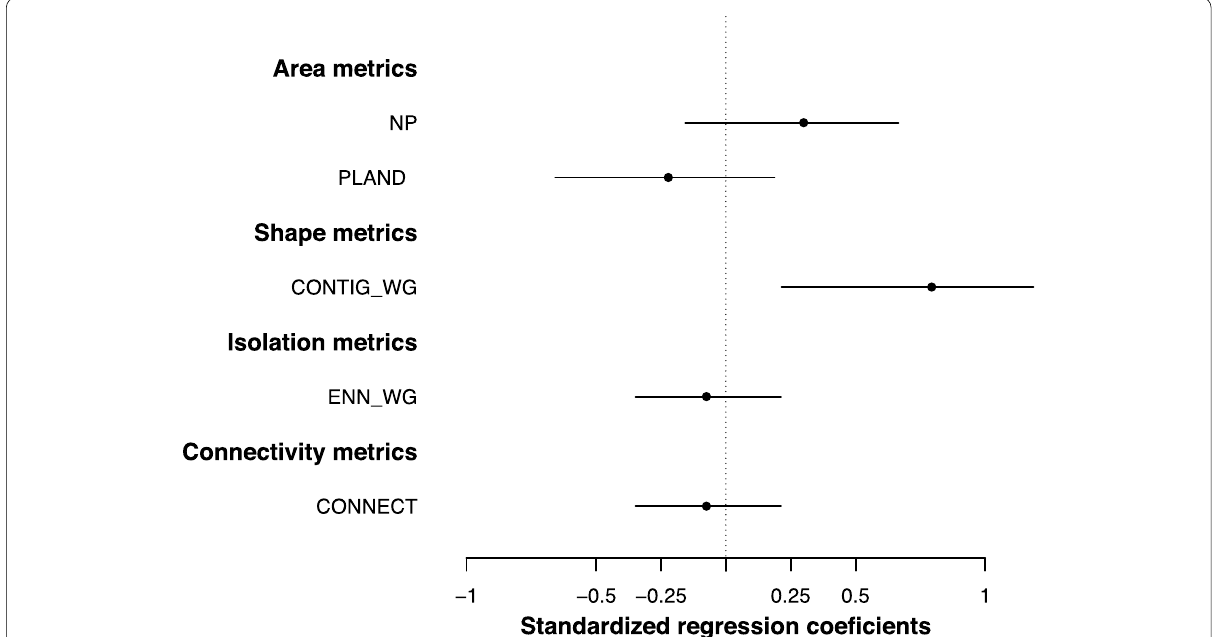
Fig. 3 Confidence intervals of the standardized regression coefficients of the BLMM model relating landscape metrics and Dromiciops gliroides abundance. The effects of landscape metrics are considered significant when their confidence intervals do not overlap the zero